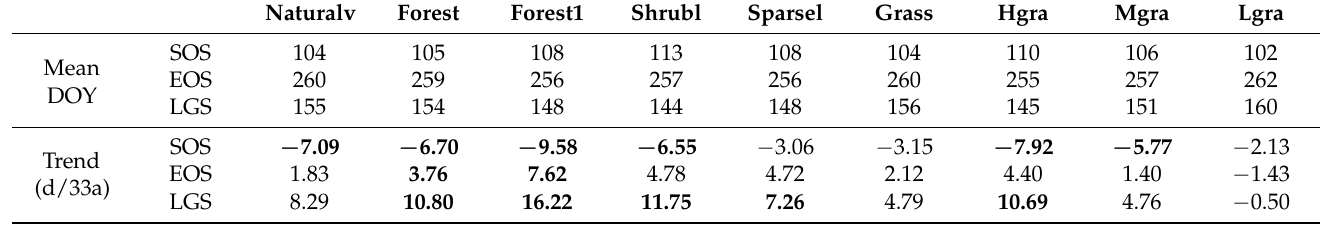
Table 1. Mean and trends (Sen slope β ) in phenological parameters of natural vegetation in the arid region of northwestern China (significant trends at the 0.05 significance level are shown in bold).